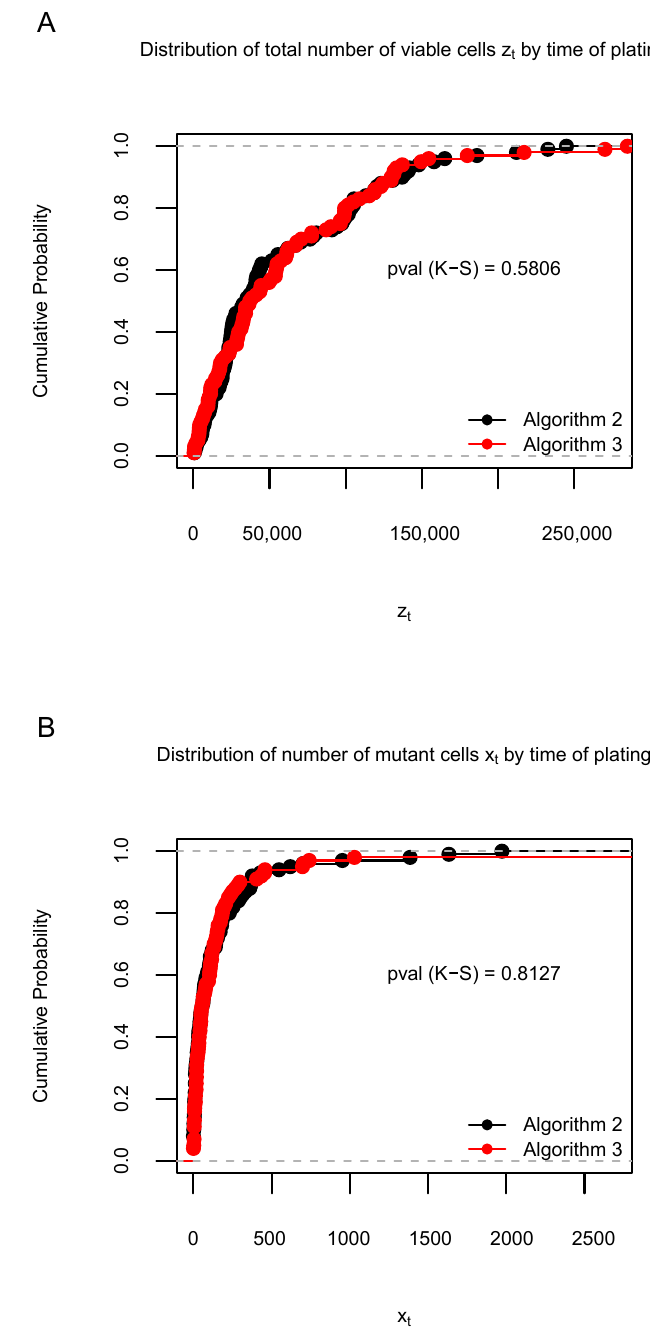
Figure A2. Distribution of 100 data samples generated by Algorithms 2 and 3 in Simulation S2. ( A ): Empirical cumulative distribution function (ECDF) of the total number of viable cells z t when the time of plating t p = 11. ( B ): ECDF of the number of mutant cells x t when t p = 11. The Kolmogorov– Smirnov (K-S) test p -values are shown under the ECDF curves. The proportions of significant K-S test p -values across 1000 simulations for z t and x t are 0.036 and 0.025,